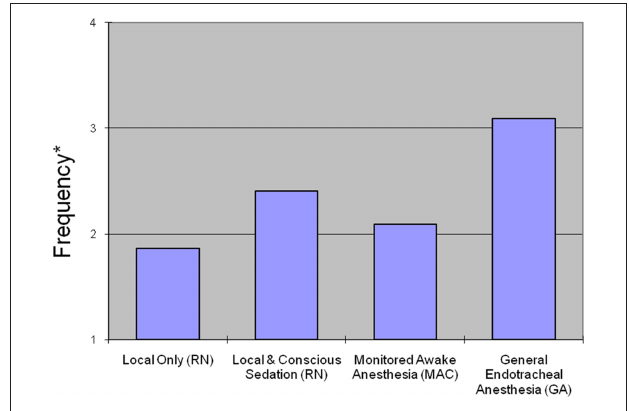
FiguRe 1 | Averaged ratings of physician’s frequency of use for four types of anesthesia. *Treated as ordinal where 1 = Never, 2 = Least frequent, 3 = Frequent, 4 = Most